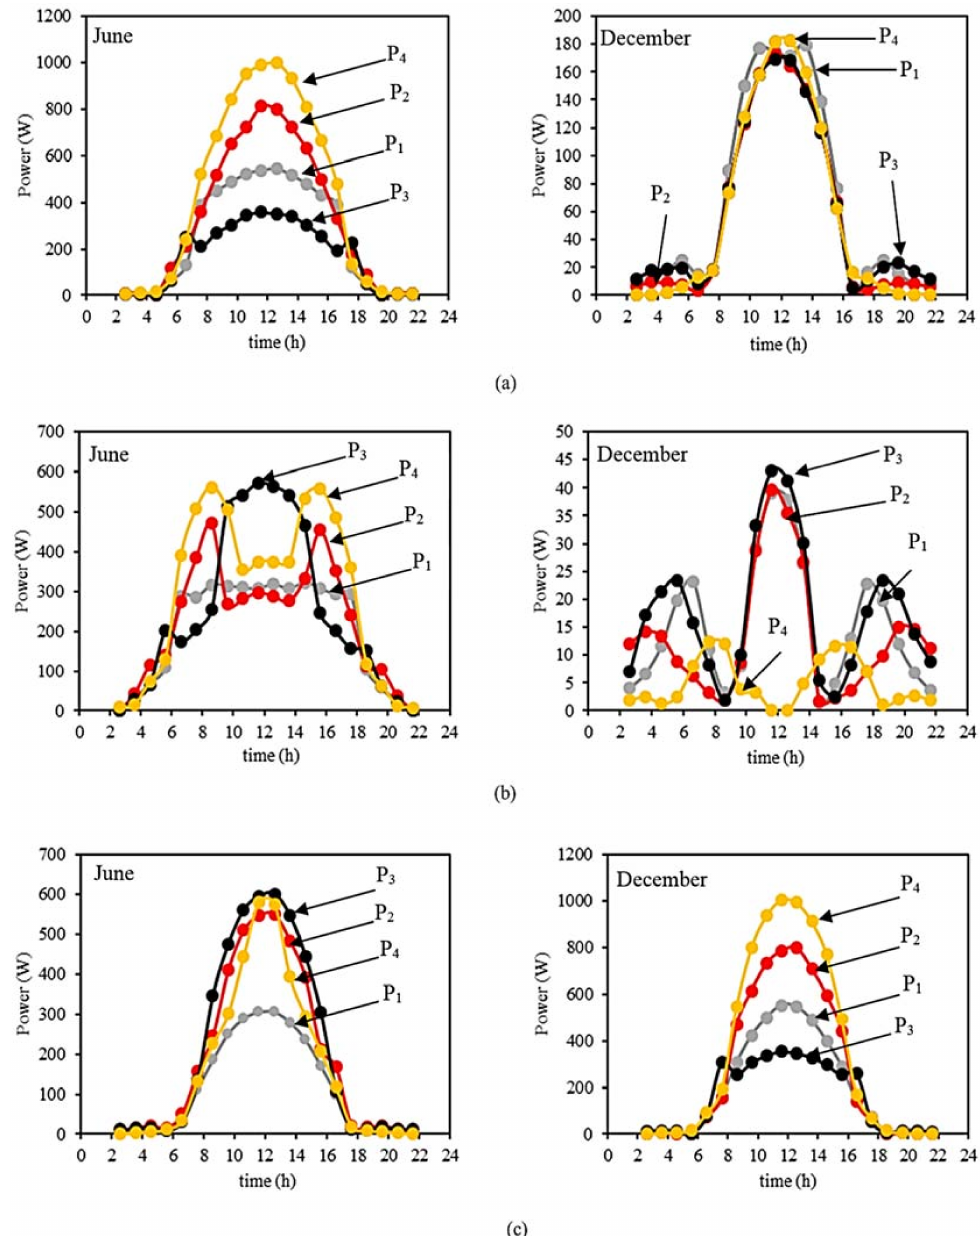
Figure 15. Collected energy per time along the solstices for the standard and proposed structures, when tilt is zero in ( a ) Lisbon, ( b ) Gavle, and ( c ) Luanda. P1—standard